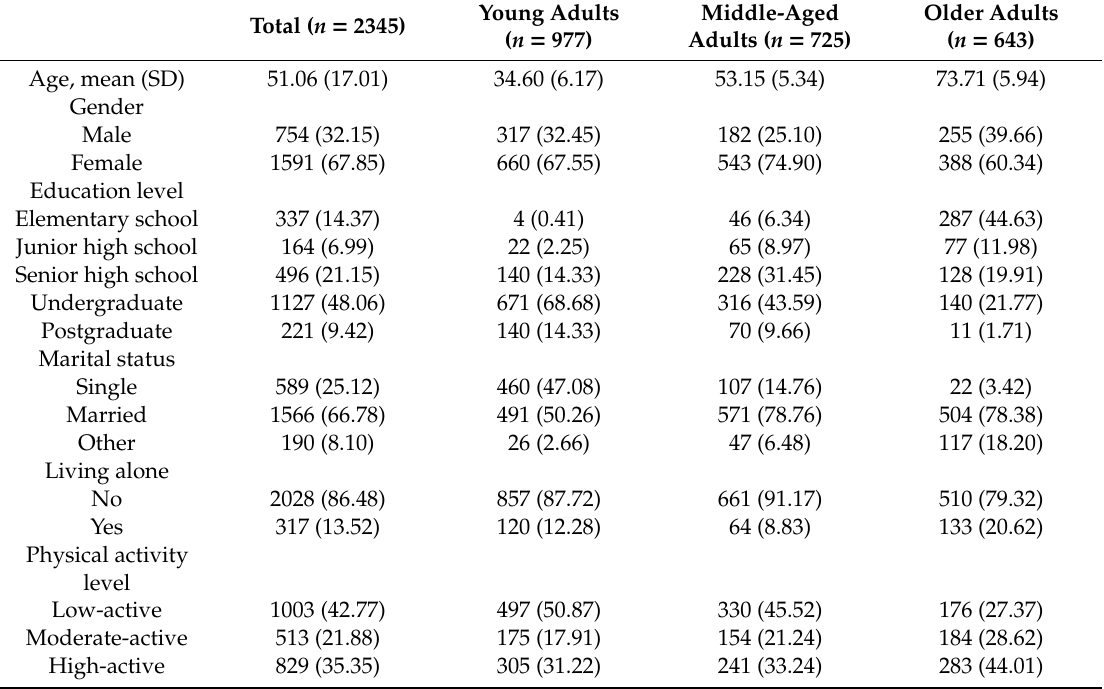
Table 1. Demographic characteristics of adults in the three age